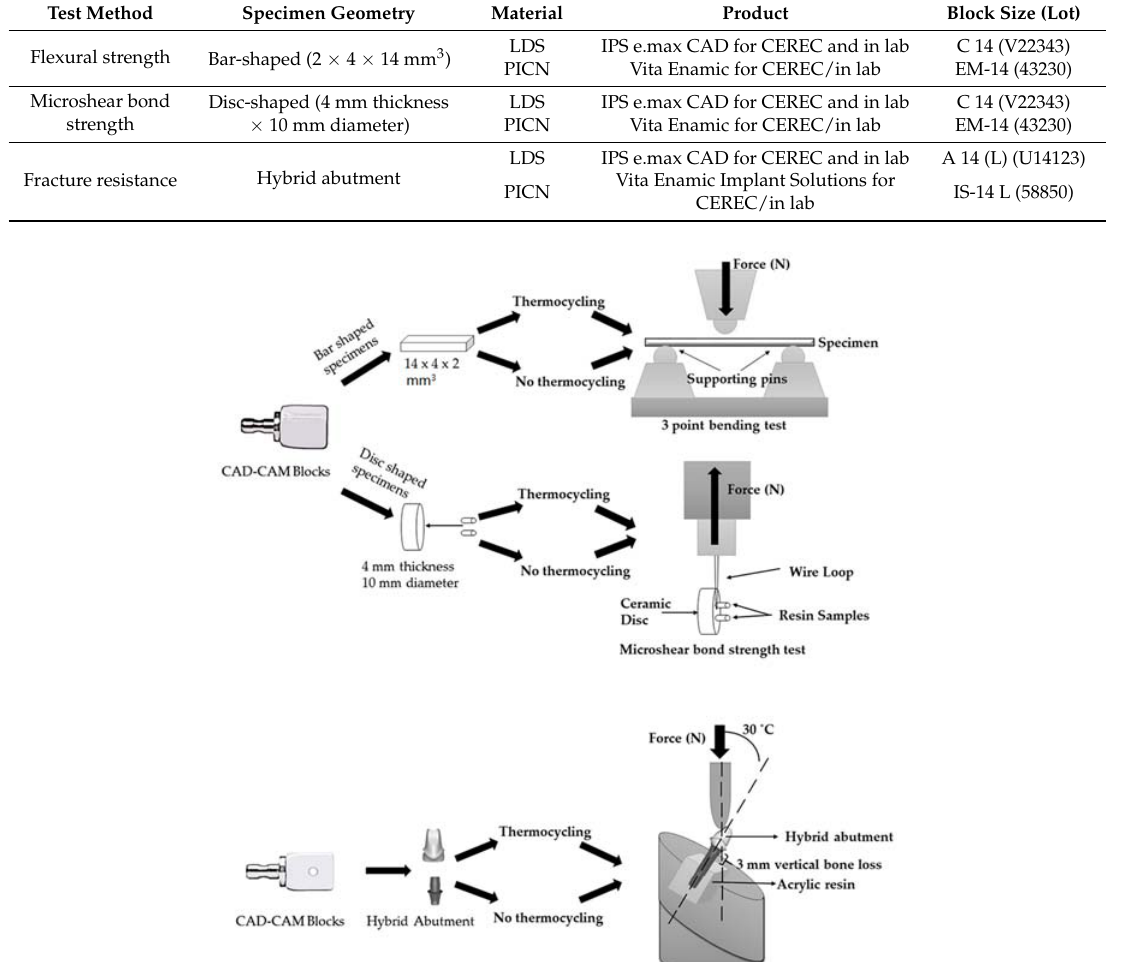
Table 1. Materials and specimen geometries used in this study.